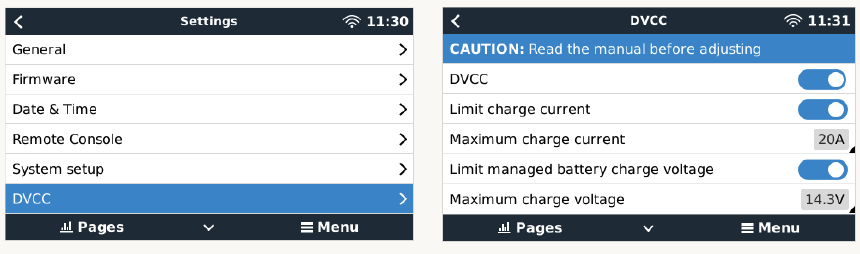
Figure 14. Distributed voltage and current control functions (DVCC).